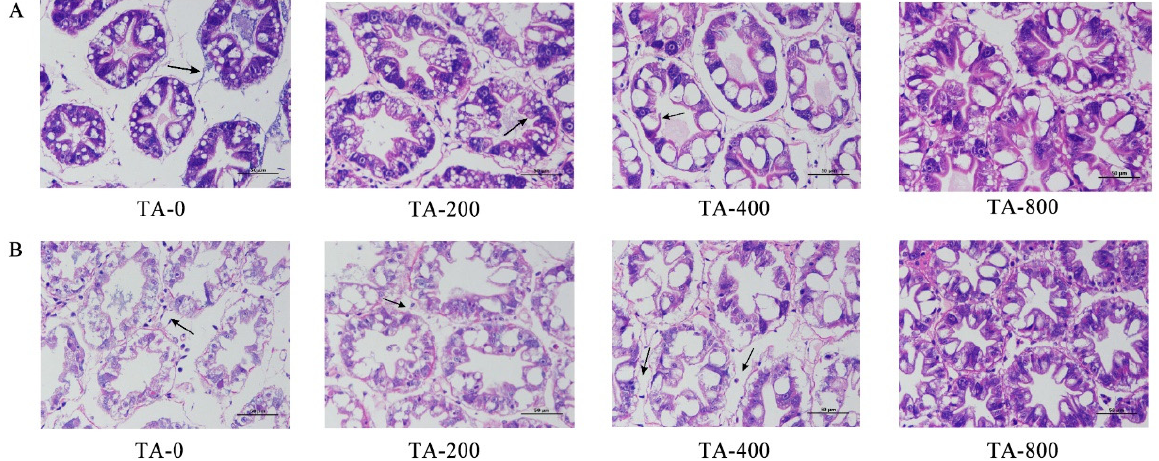
Figure 2. Hepatopancreas histology of L. vannamei in the feeding trial after 56 days and ammonia stress after 48 h. ( A ) The feeding trial lasted 56 days; ( B ) ammonia stress lasted for 48 h. Whole segments were marked with H&E. Scale bar: 50 µ m. The arrows in the figure indicate the differences between the treatment groups.